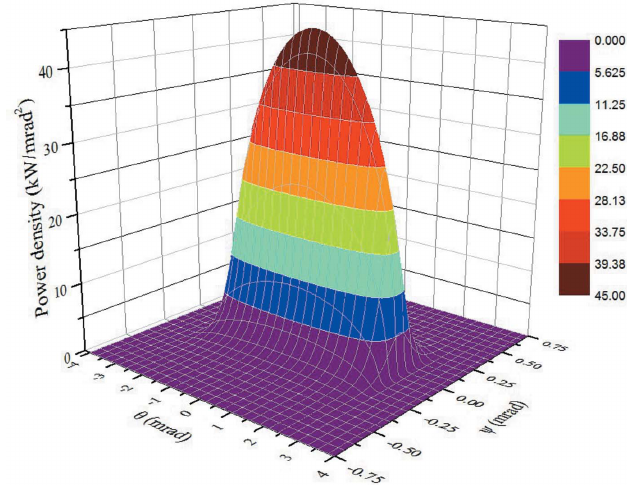
Figure 3 Power density distribution of the superconducting